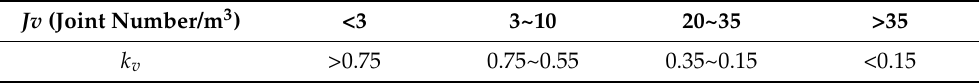
Figure 9. ( a ) Ratio of slate thickness to total underwater slope height. ( b ) Failure index λ of toppling deformation body. Table 5. Comparison of J v and k v